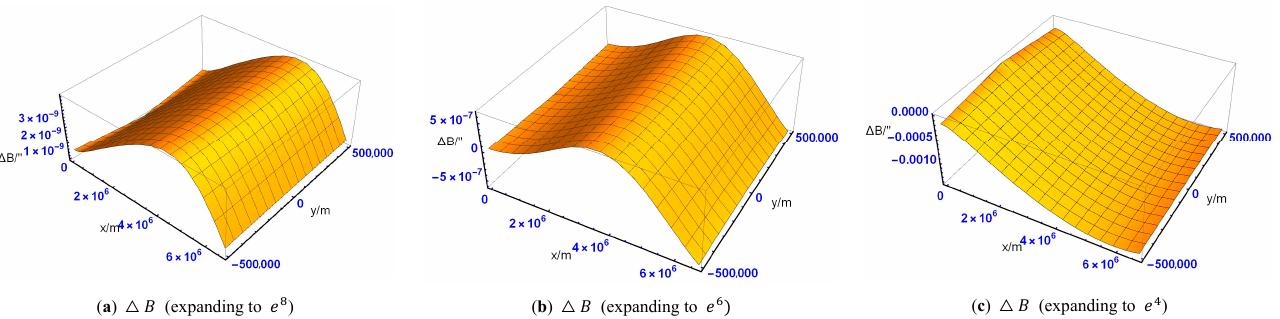
Figure 8. The distribution of the latitude truncation difference ∆ B when expanding to e 8 , e 6 , and e 4 .